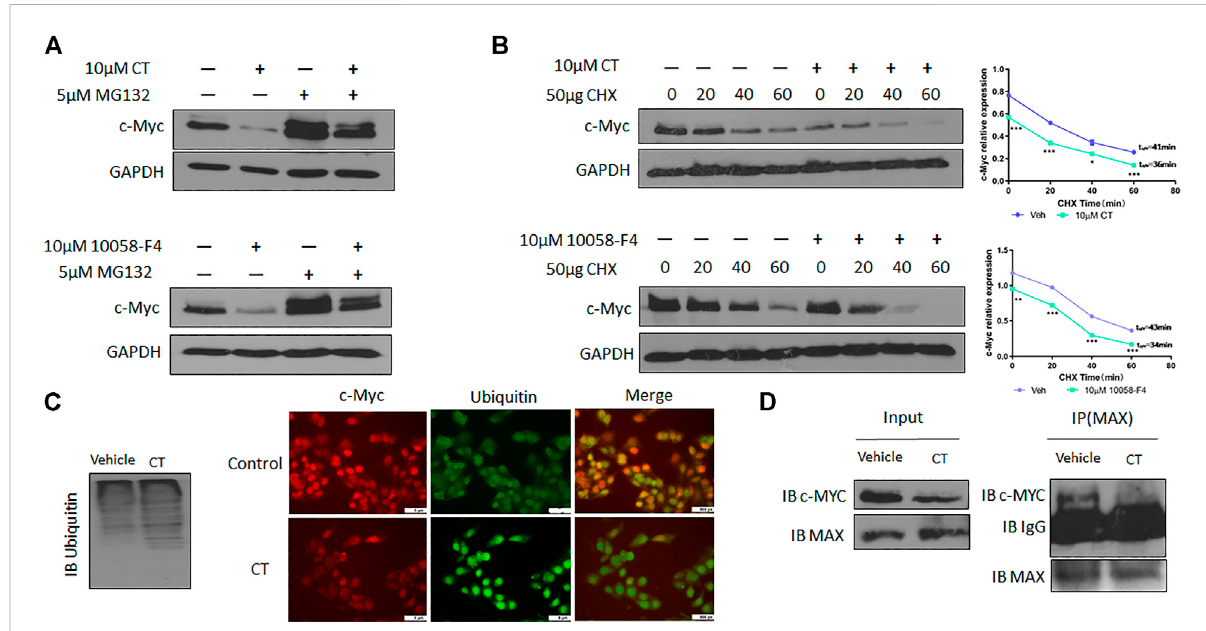
CTdegradesc-Mycthroughubiquitinationpathway. (A) c-Mycexpression inOVCAR3cells treatedwith 10 μ MCT or10058-F4 with or without the proteasome inhibitor MG132 was determined by immunoblot. (B) OVCAR3 cells were pretreated with 10 µM CT or DMSO for 24 h, followed by 50 μ g/ml CHX treatment and c-Myc expression was detected by immunoblot. (C) Immunoblot analysis of ubiquitination in OVCAR3 cells treated withvehicleorCTandimmuno fl uorescentstainingofc-Myc(Red)andubiquitin(green)inOVCAR3cells24 haftertreatmentwithCTorvehicle